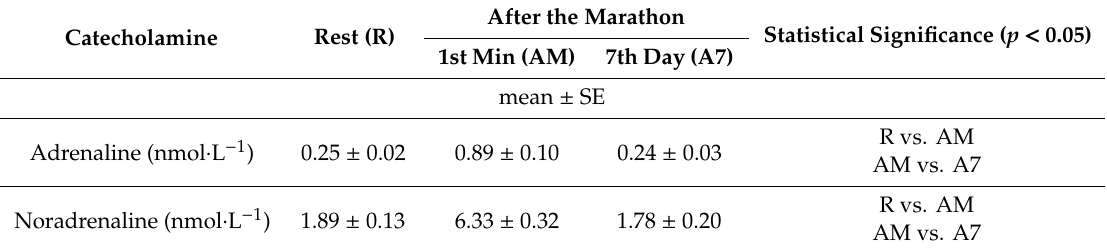
Table 2. Catecholamine levels in plasma before and after the marathon race.